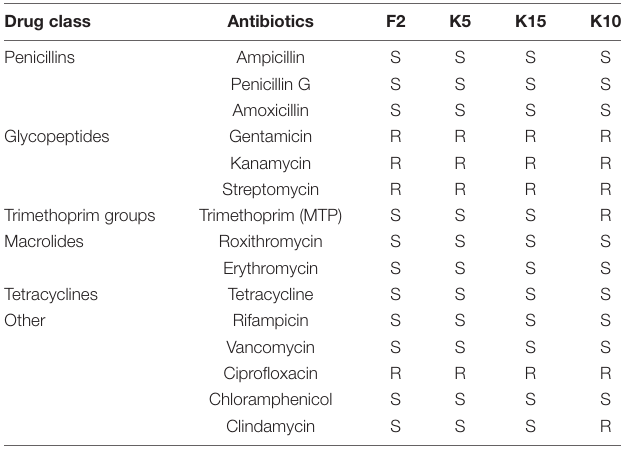
TABLE 3 | Antibiotics susceptibility of the selected B. longum subsp. longum strains.